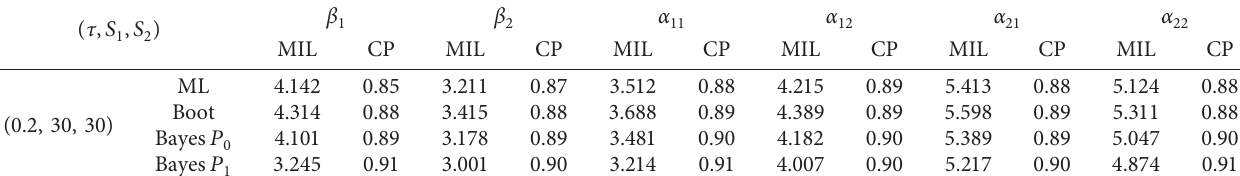
Table 6: The MILs and CPs of ML, boot, and Bayes methods under ω � 2 . 0 , 1 . 2 , 1 . 3 , 1 . 8 , 2 . 0 , 2 . 0 { }